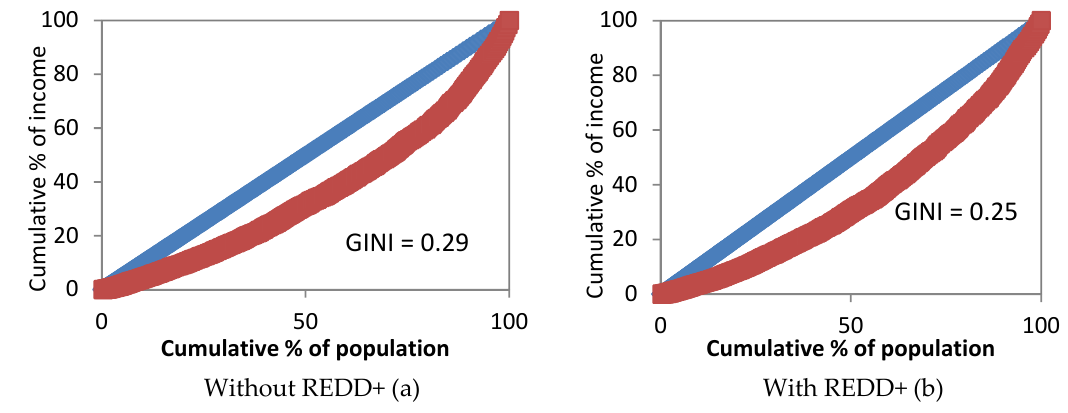
Figure 7. Lorenz curve of farmers in Con Cuong District, Nghe An Province. ( a ) Without REDD+; ( b ) With REDD+.